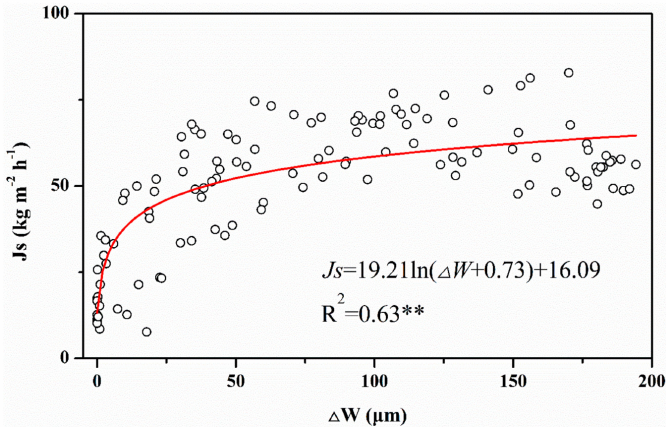
Figure 3. The relationship between sap flow density (Js) and tree water deficit ( ∆ W) for Qinghai spruce from May to August of 2016 after removed several outliers in the constant heavy rainy days and 2–5 days after heavy rain. ** p <